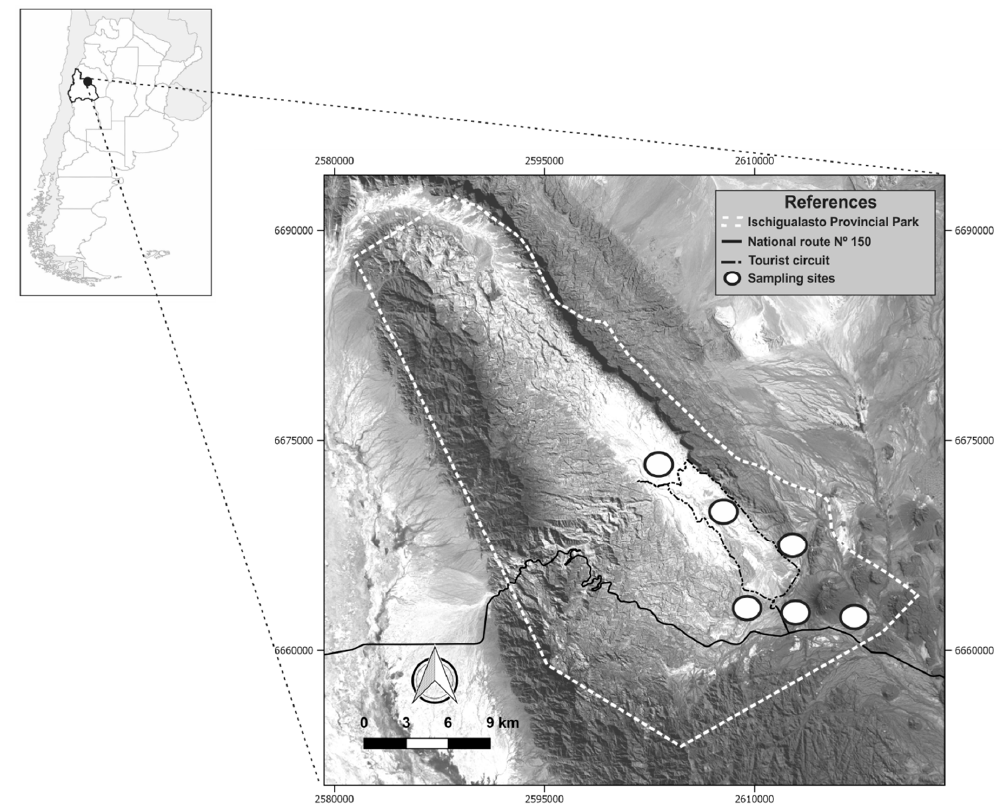
Figure 1. Geographic location of Ischigualasto Provincial Park, San Juan, Argentina and sampling sites locations.